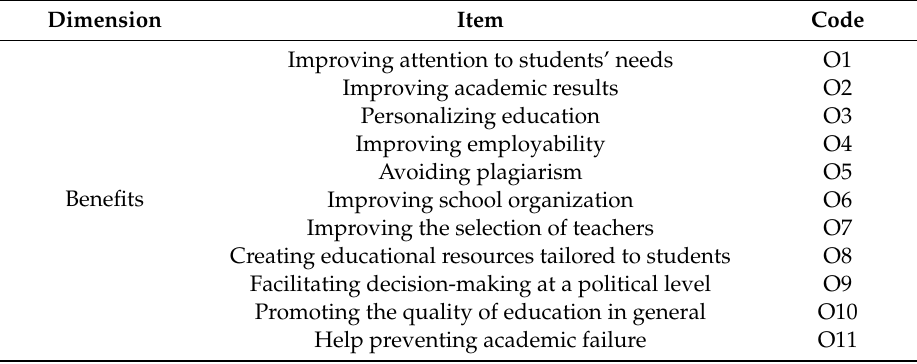
Table 1. Assessment of Big Data Applied to Education (VABIDAE)